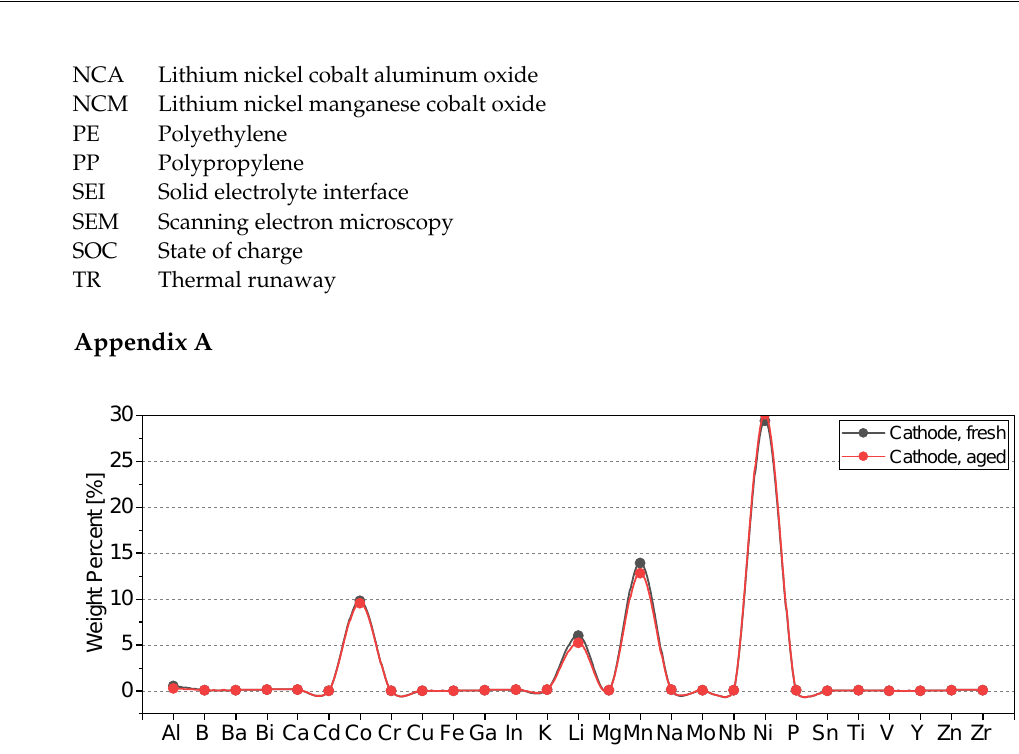
Figure A1. ICP-OES results of the fresh and aged cathode